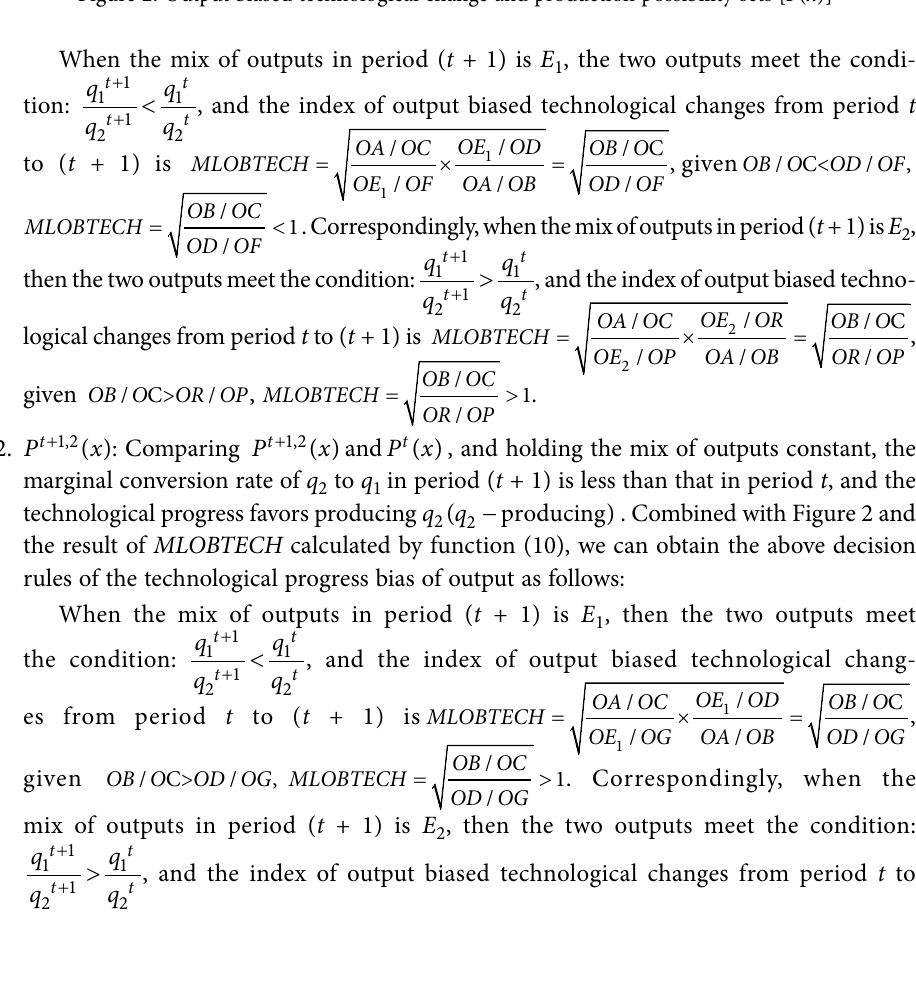
Figure 2. Output biased technological change and production possibility sets [ P ( x